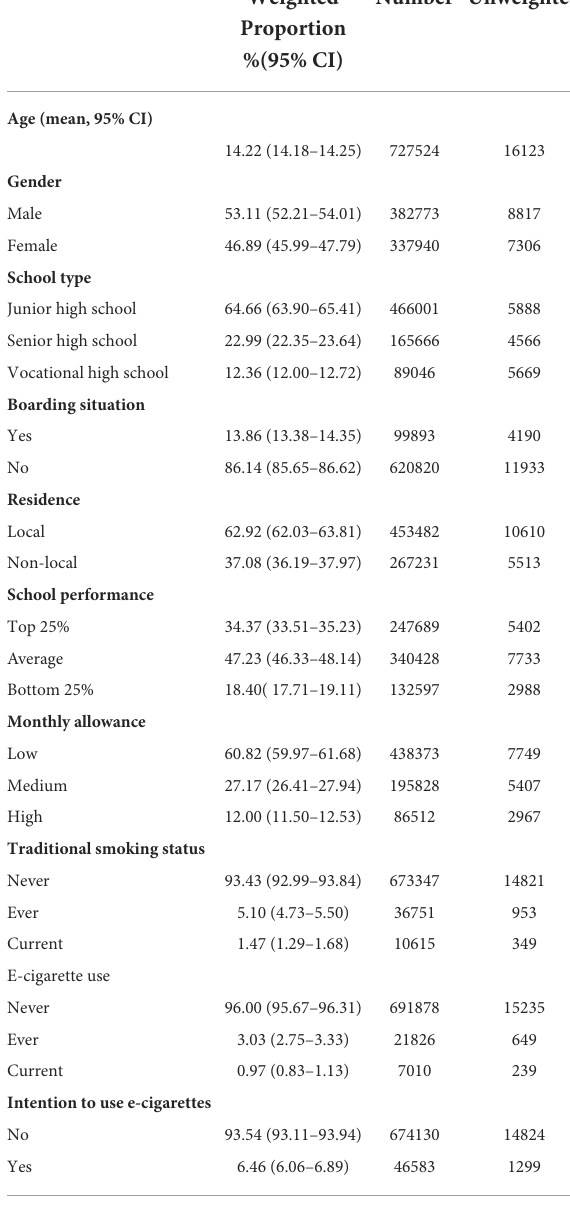
TABLE 1 Baseline